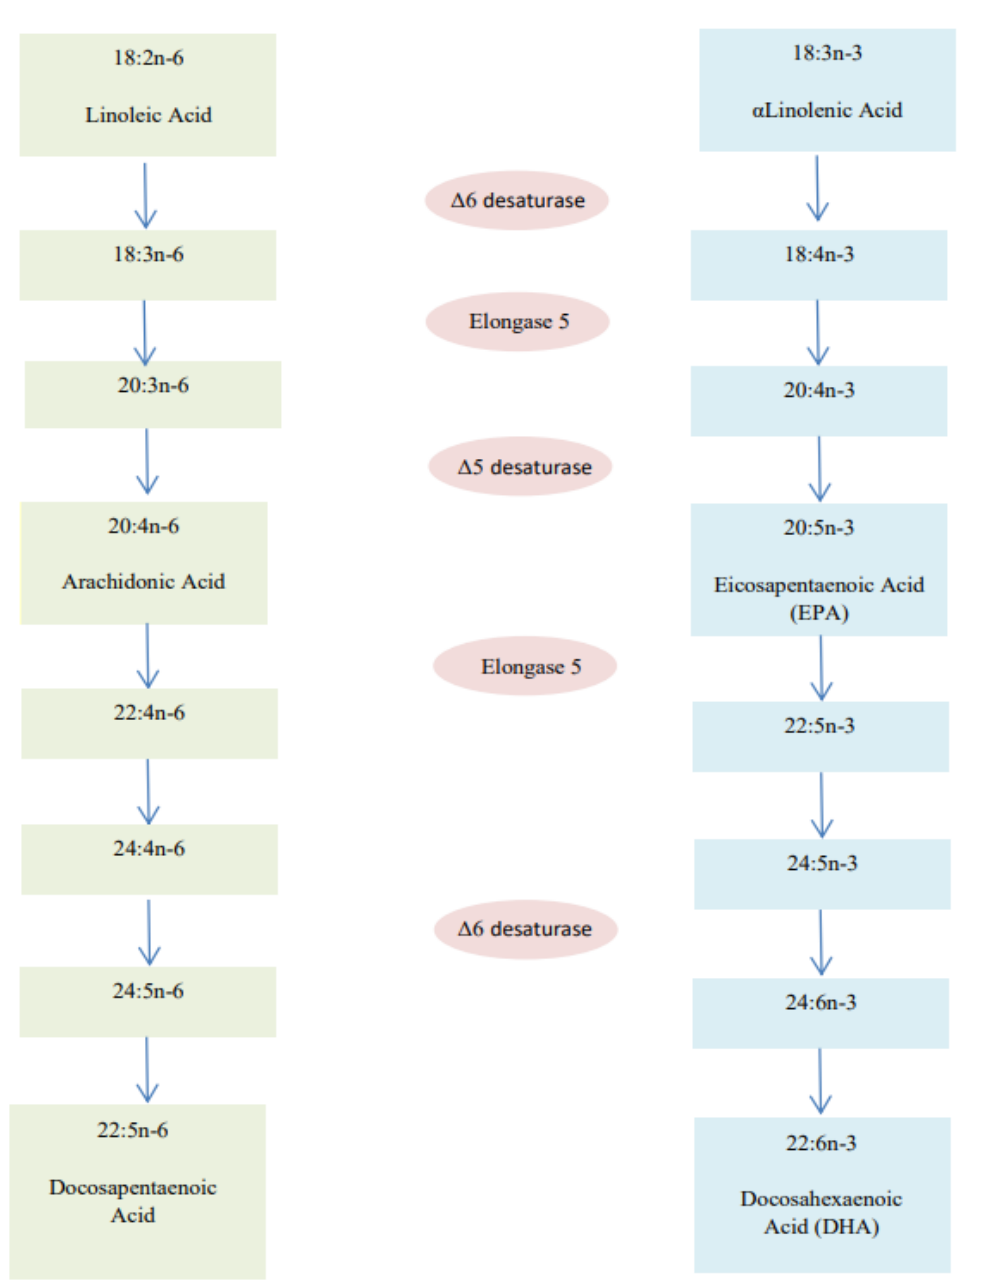
Figure 2. Pathway of long-chain polyunsaturated fatty acid (LCPUFAs) biosynthesis from essential fatty acid precursors